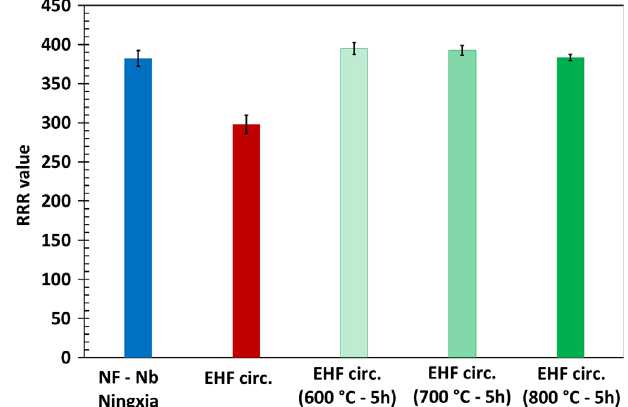
FIG. 12. RRR values obtained for nonformed niobium (NF — Nb) and for half-cells formed by EHF or spinning. “ Circ. ” indicates specimens which were extracted circumferentially close to the iris.